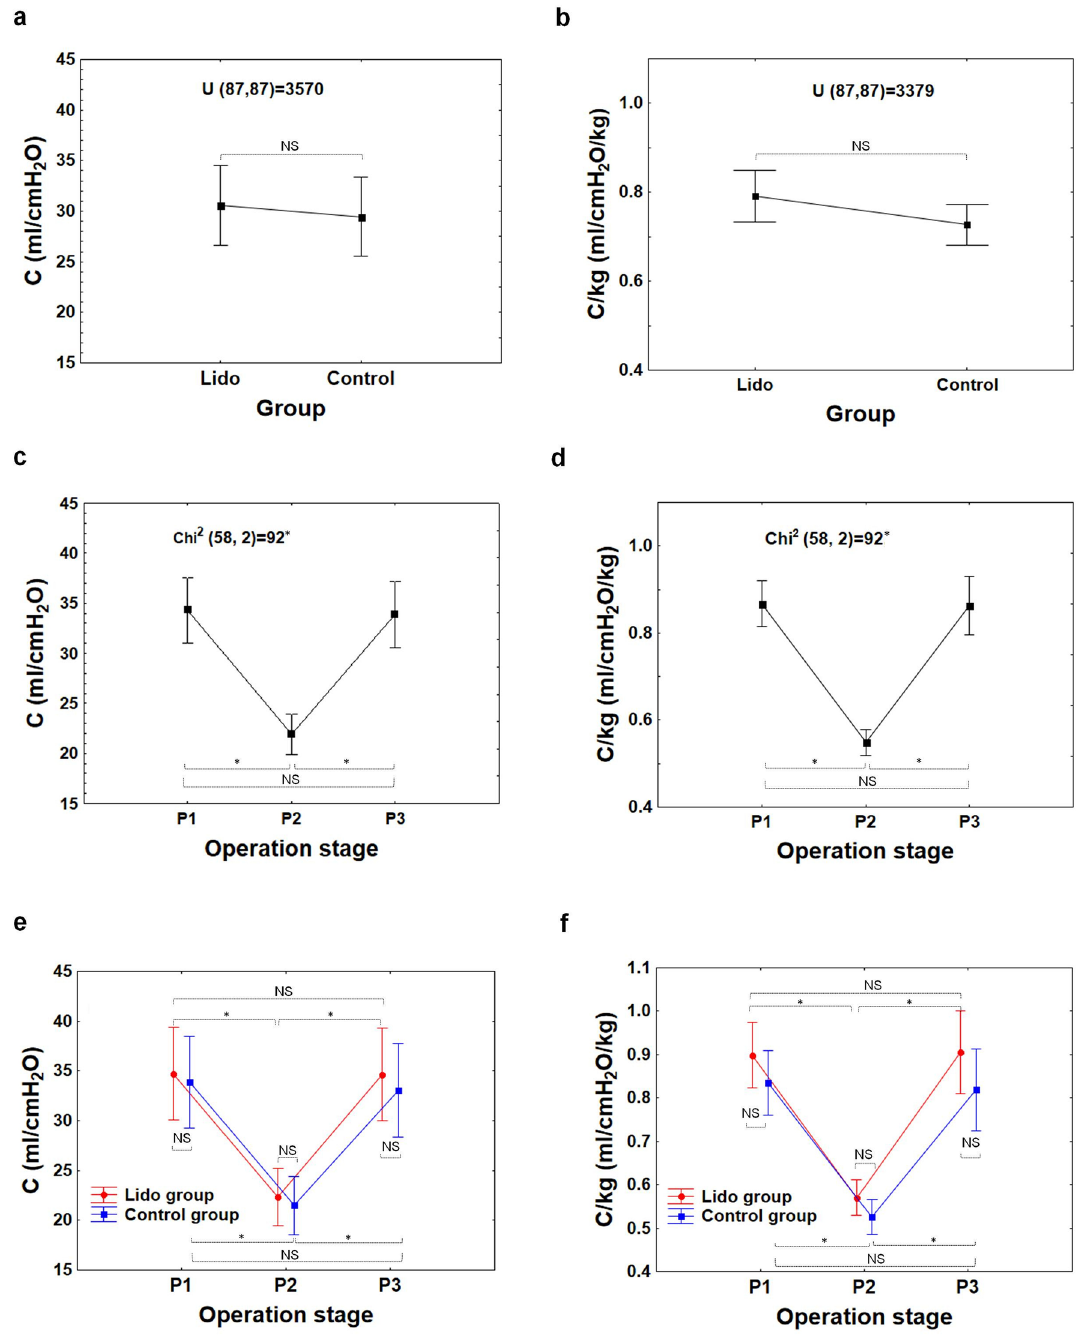
Figure 3. Compliance of respiratory system C, compliance of respiratory system per kg of body mass C/kg at the beginning (P 1 –baseline), during (P 2 ) and at the end of surgery (P 3 ) in the Lido and Control group. The differences between patients’ groups are insignificant (NS), ( a , b ). The differences between the P 1 , P 2 and P 3 stages are significant ( c , d ); *P < 0.001 (1 − β = 0.99 for α = 0.001). The difference between Lido and Control group at the P 1 , P 2 and P 3 level is insignificant (NS), ( e , f